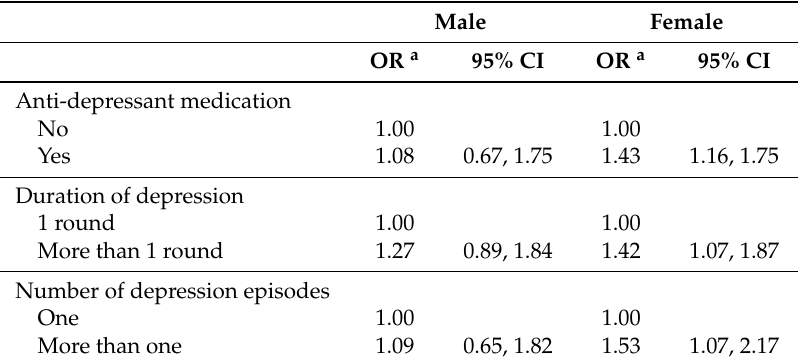
Table 6. Proportional odds of occupational injury by depression characteristics among depressed workers in the MEPS population, stratified by